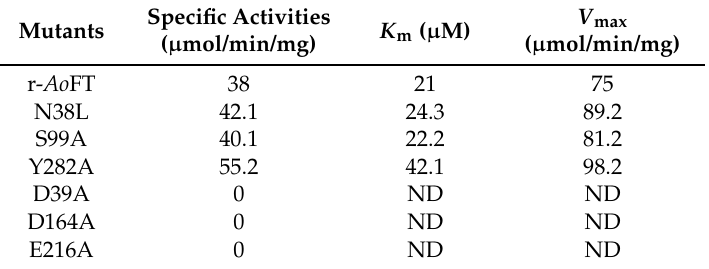
Table 4. Comparison of transfructosylation activity of the wild type r- Ao FT and key amino acid mutants.